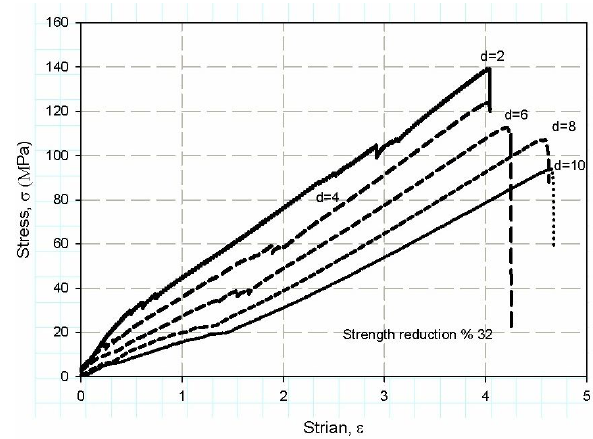
Fig. 5. Stress Strain diagram of different glass fiber composite plat